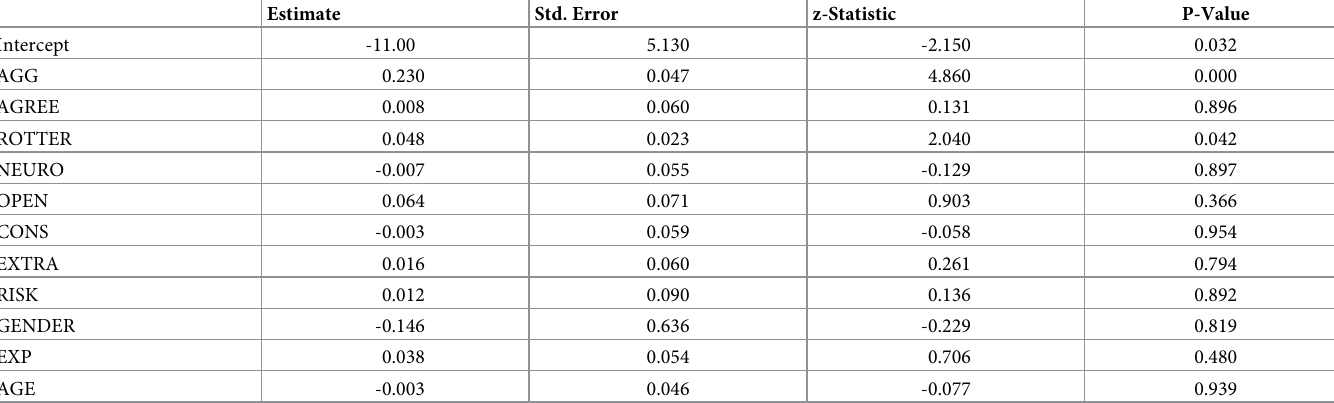
Table 7. Determinants of investing vs. tracking in the baseline treatment combining E1 and E2. The table presents the results of a multivariate logistic regression in which the dependent variable is the invest/track decision and the independent variables are personality, risk preference, and demographic information for the